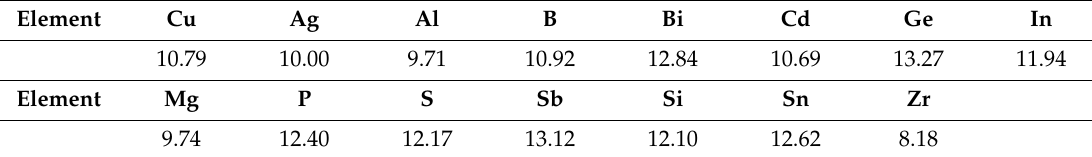
Table 7. The charge number of the bonding states a ff ected by alloying elements. Element Cu